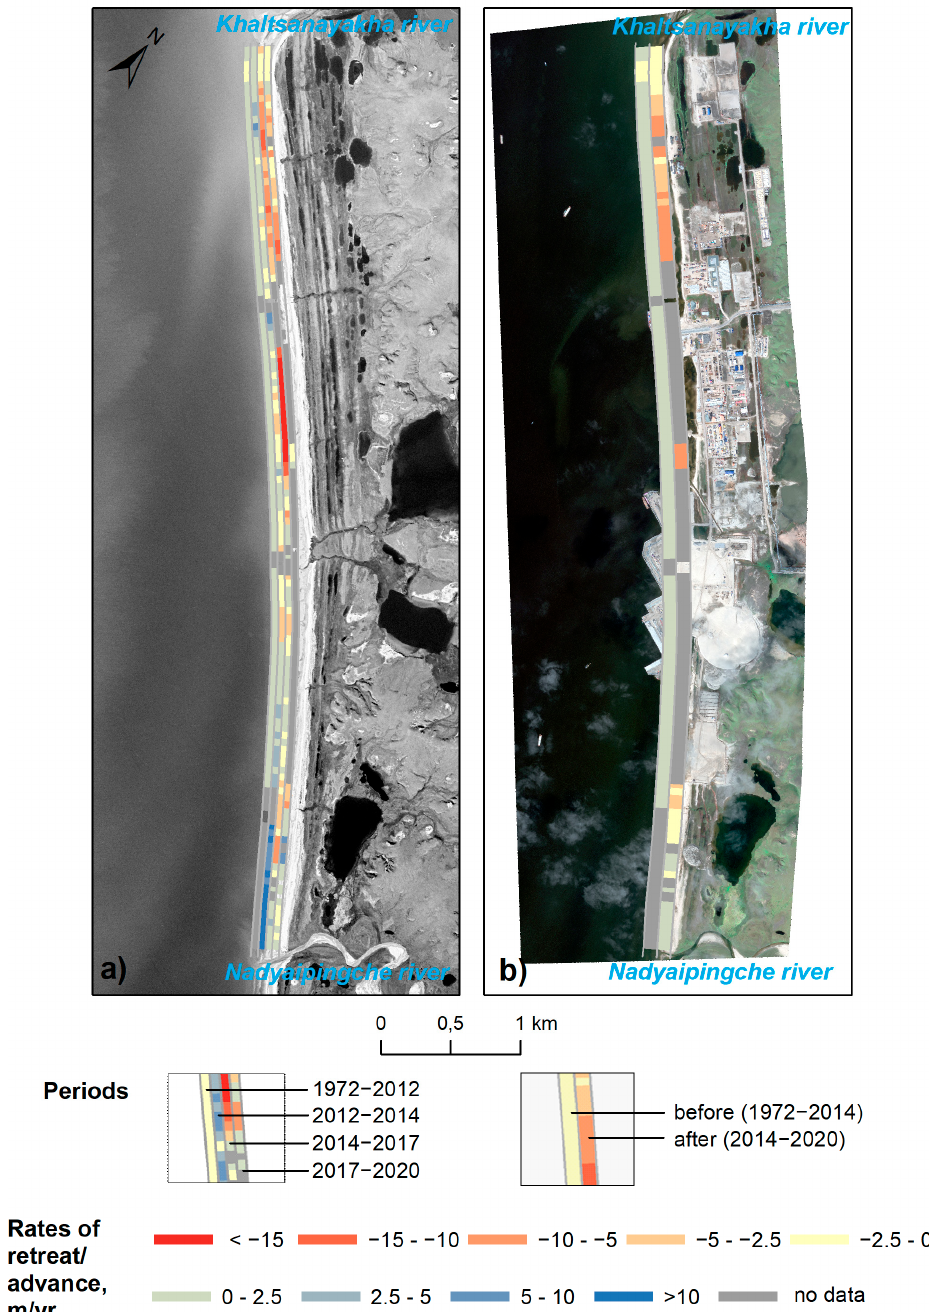
Figure 8. Vegetation line dynamics ( a ) by different periods (1972–2012, 2012–2014, 2014–2017,